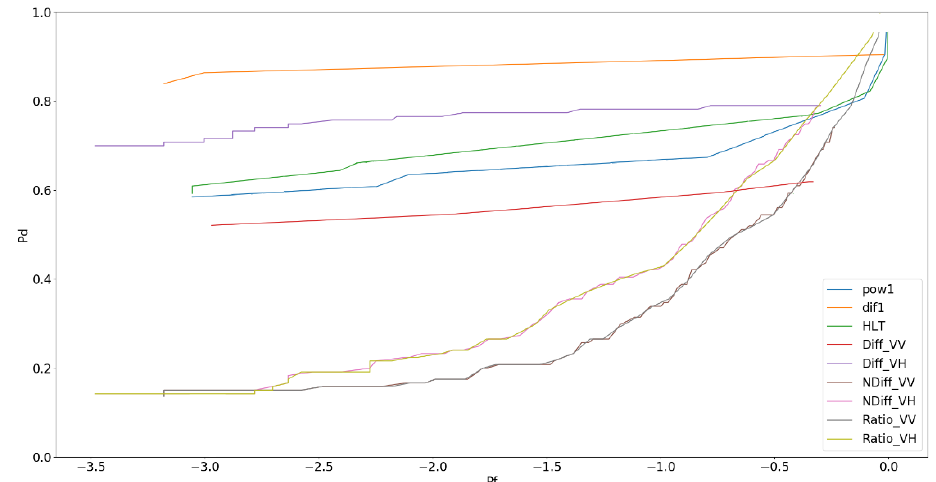
Figure 11. ROC Curve in a Log10 format showing River Drina Data change detectors: Difference VV & VH (Diff_), Ratio VV & VH (Ratio_), Normalised Difference (NDiff_), Power Difference (Dif1), Power Ratio (Pow1), and Trace (HLT).